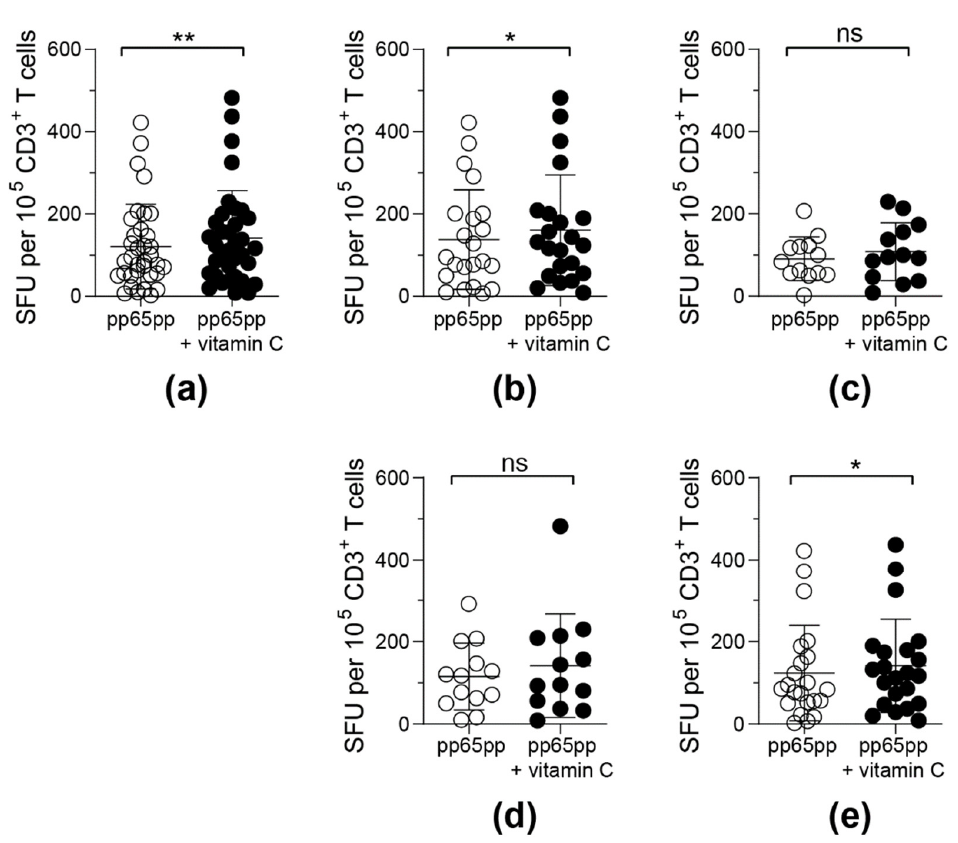
Figure 4. Frequencies of detectable IFN- γ -secreting antigen-specific T cells upon pre-treatment with vitamin C for 3 days. PBMCs were incubated with or without 50 µM vitamin C for 3 days followed by activation via pp65pp. By using IFN- γ ELISpot assay, spot forming units (SFU) per 10 5 T cells were determined. Each symbol represents one donor. ELISpot results obtained